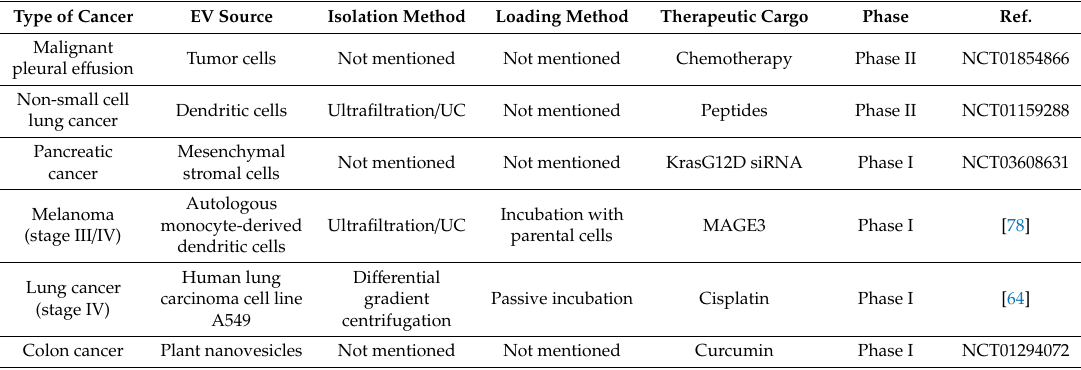
Table 2. Clinical trials with EVs as drug delivery